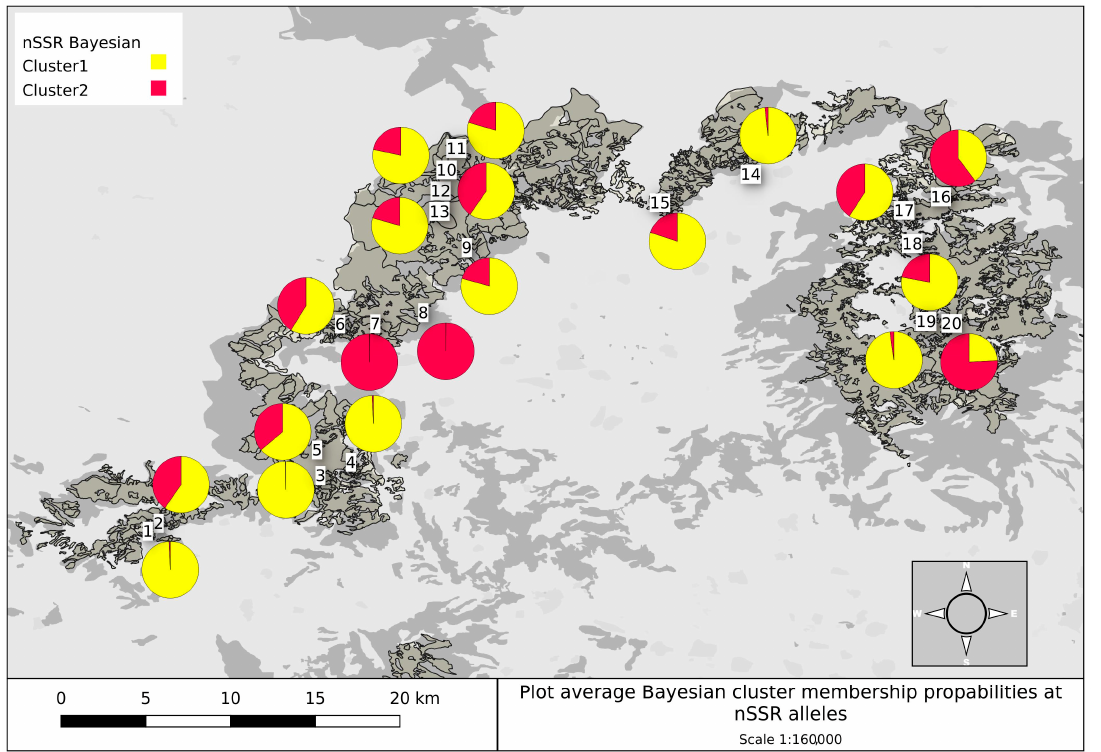
Figure 5. Map of the average Bayesian cluster membership probabilities of the nSSR gene loci for beech in the 20 plots of the study.